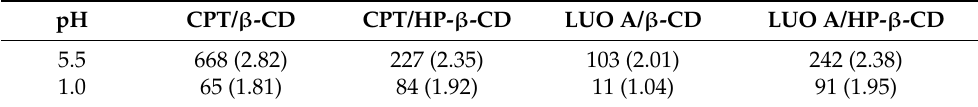
Table 1. Association constants, given as K ass (log K ass ), obtained for the cyclodextrin complexes of camptothecin and luotonin A in aqueous solution at two pH